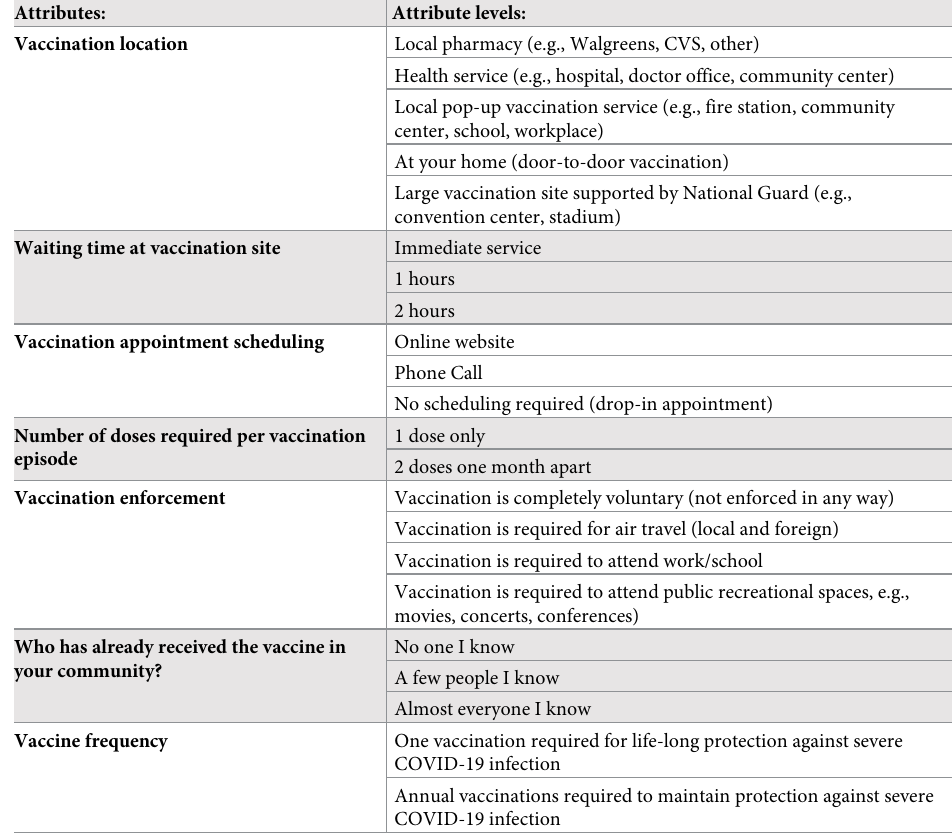
Table 1. Choice experiment attributes and attribute